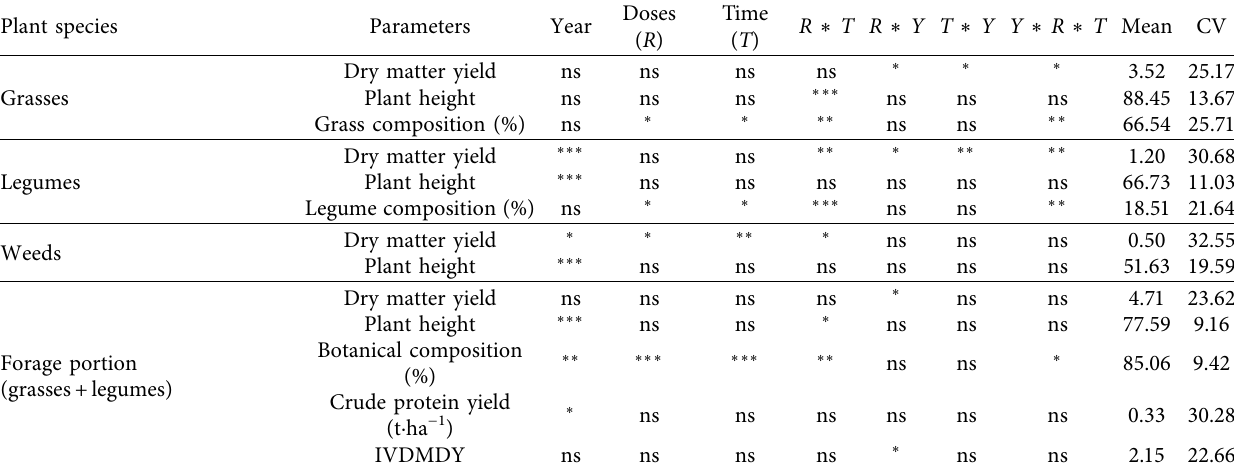
Table 4: Effect of year, doses, and time of application of 2, 4-D herbicides and their interaction on plant height (cm), dry matter, and crude protein yield (t · ha − 1 ) of pasture land plant species.